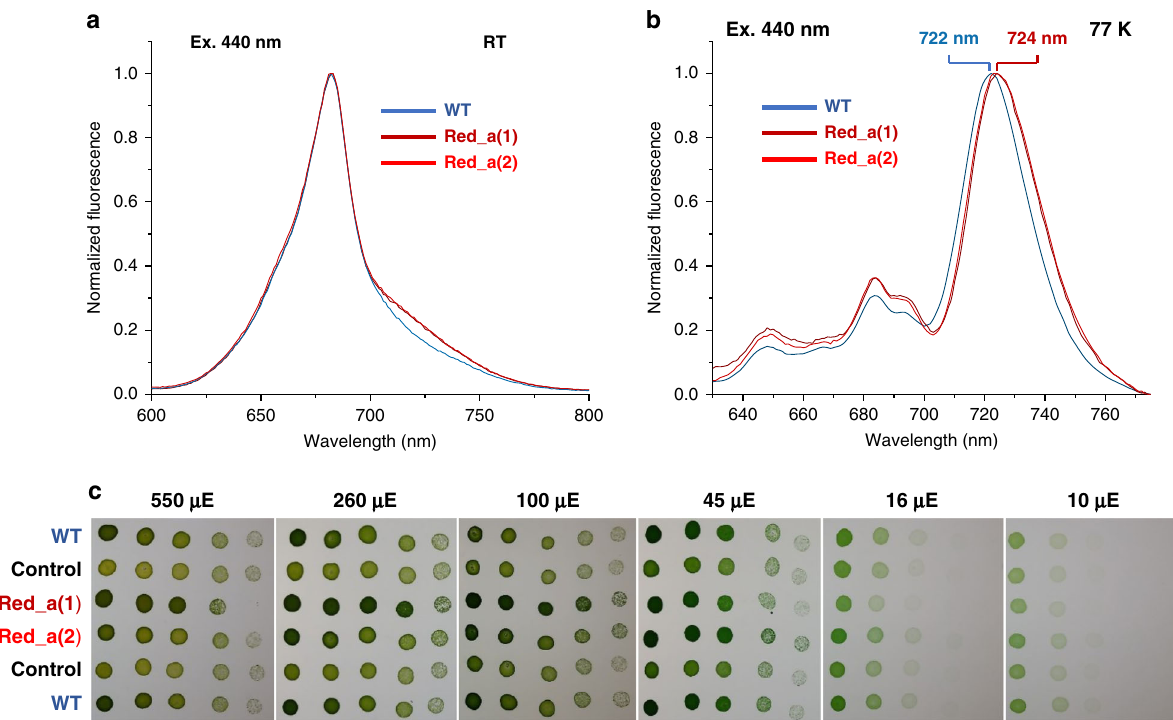
Fig. 2 Spectroscopic properties and physiological effect of Red_a in cells. a , b Fluorescence emission from WT (blue) and two independent Red_a isolates (Red_a(1/2)) cells at room temperature ( a ) and 77 K ( b ). c No growth differences between WT and Red_a cells were found over a range of light intensities. (5-fold serial dilutions of each strain were incubated on BG-11 plates without added glucose, pictures were taken after 10 days of incubation at 30 °C). Control lines contain the antibiotic resistance gene used in the Red_a strains but do not carry the Red_a